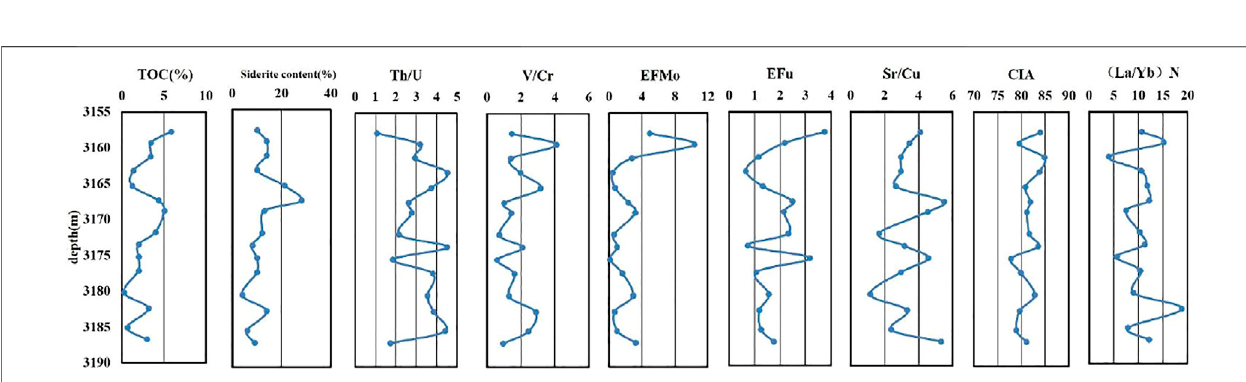
FIGURE8| VerticaltrendofTOC,waterredoxindicators[Th/U,V/Cr,EF(Mo),andEF(U)],paleoproductivityindicators(MoandP),paleoclimateindicators(CIAand Sr/Cu), and the vertical variation trend of the deposition rate index ((La/Yb)N) of Longtan Formation mud shale in Well X1.